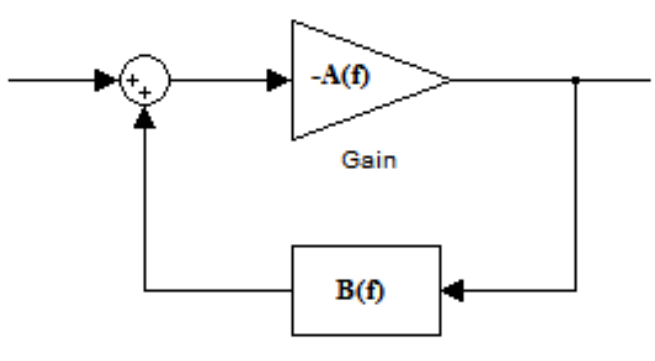
Figure 9. Feedback system for an